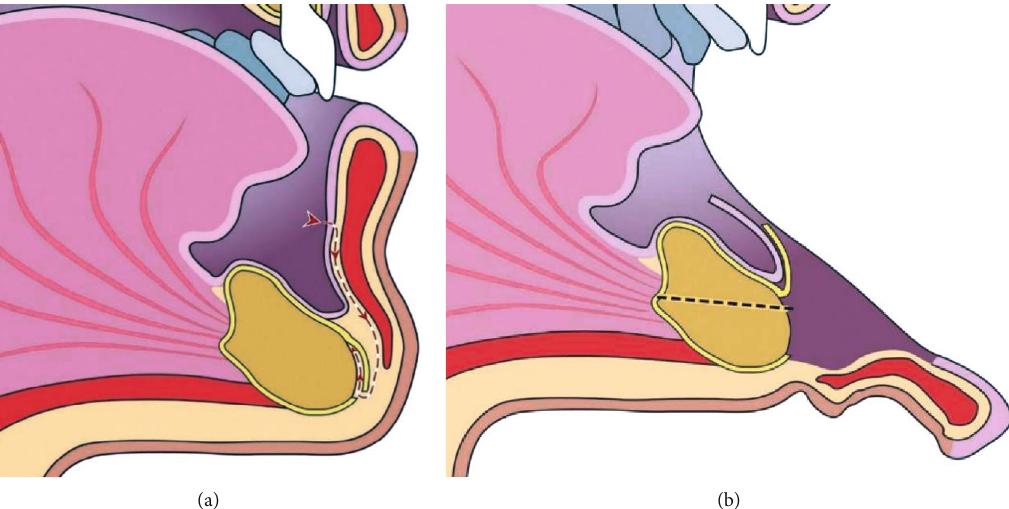
Figure 1: Schematic drawing showing (a) soft tissue preparation technique and (b) de fl ected tissues after dissection and the osteotomy line.